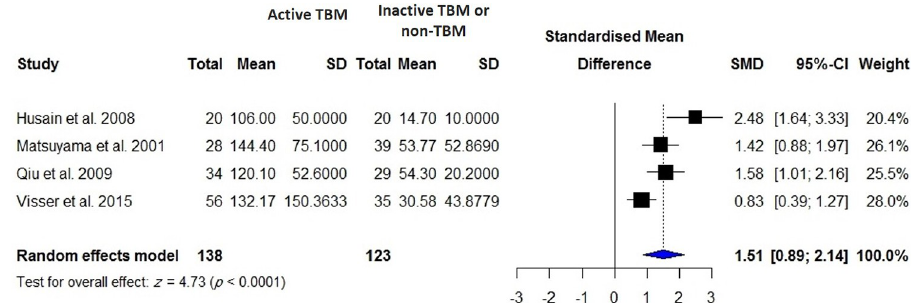
Fig 7. Meta-analysis of CSF VEGF levels in patients with active TBM vs. controls including inactive TBM or non- TBM